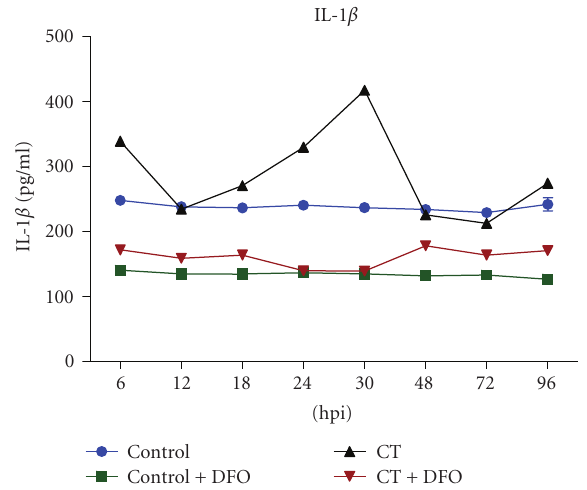
Figure 3: Levels of IL-1 β in supernatants of C. trachomatis infected culture were significantly decreased ( P < 0 . 005) at early (6, 12, and 18hpi) and late (72 and 96hpi) time points in comparison to mock infected culture, whereas at midtime point no significant ( P < 0 . 001) change was observed.